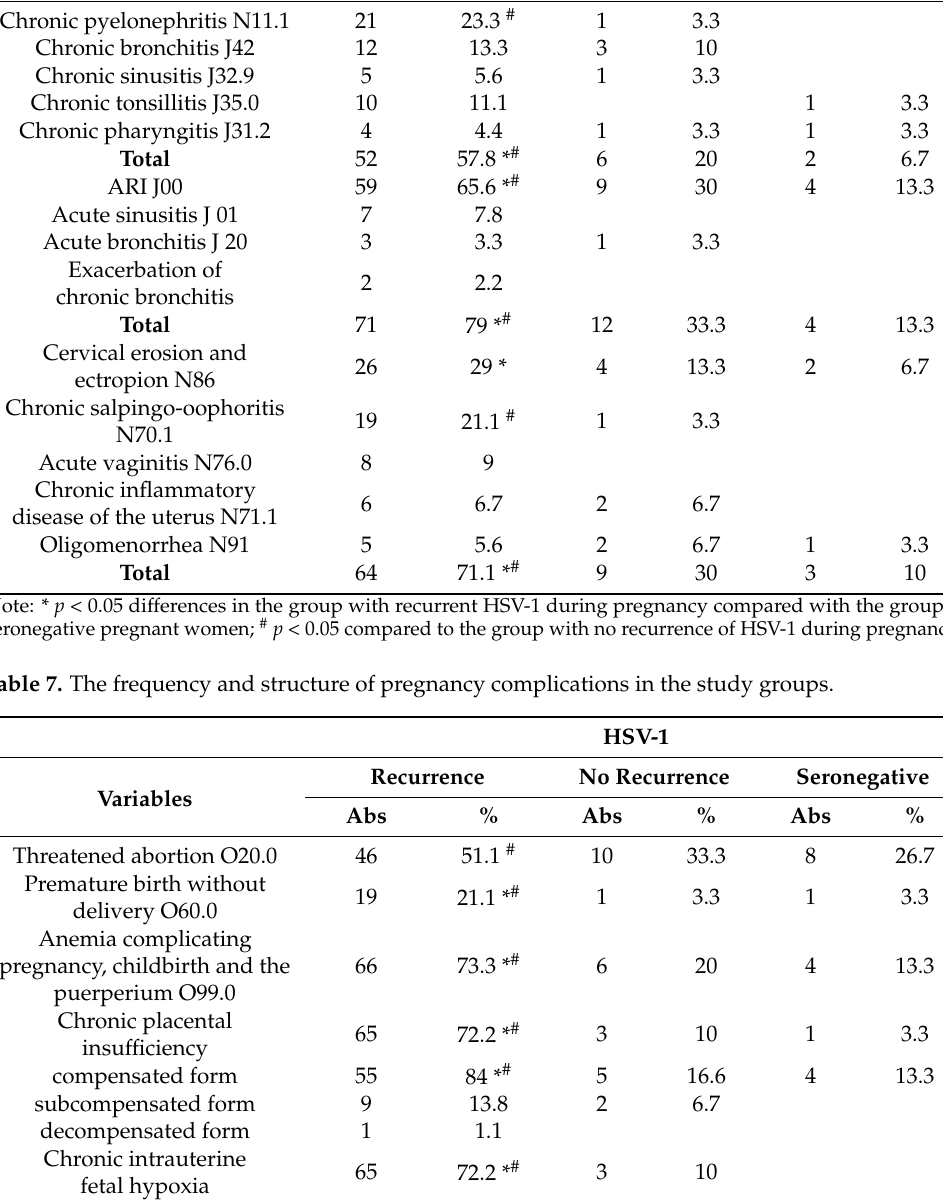
Table 6. The frequency and structure of somatic and gynecological diseases in the study groups. Variables Chronic pyelonephritis N11.1